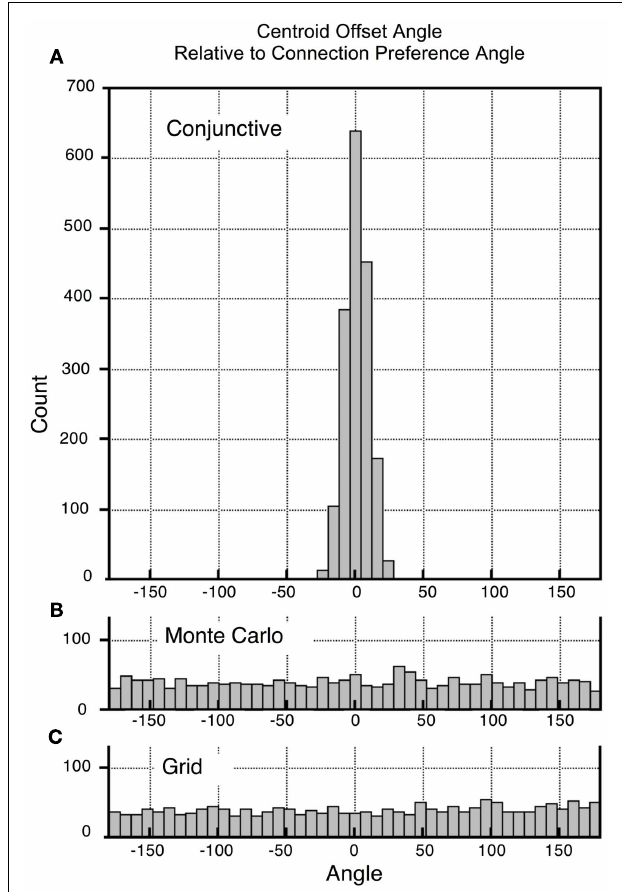
FIGURE 11 | Histograms of centroid offset angles for all cells in a simulation. Recall that Figure 10 illustrates that the displacement centroid for 3 groups of connections are in the direction of the common heading preference of the cells.To prepare this figure similar centroid offset calculations were made for all 1800 possible subsets. Each centroid-offset-angle was subtracted from the common heading preference and the results plotted as a histogram. As predicted, common heading preference and offset angle are very similar. (A) For the conjunctive cell module, the angle difference clustered around 0, with a maximal deviation of 27˚. Mean unsigned deviation was 6.7˚. (B,C) Perform similar calculations on Monte Carlo simulations of direction pairs (B) and grid cell pairs where heading preference was randomly assigned. For each of these “random” simulations produced flat distributions, with deviations from 0 averaging ∼